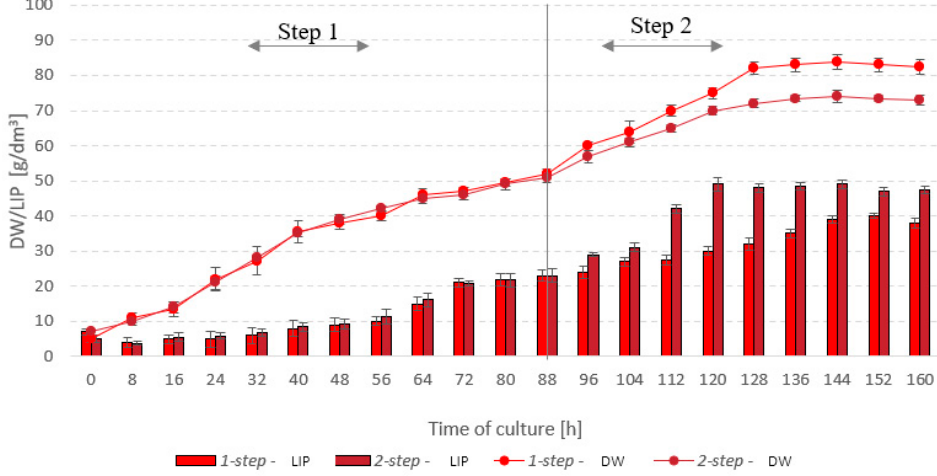
Figure 7. Trends in microalgal biomass and lipid concentrations—one-step vs two-step culture.